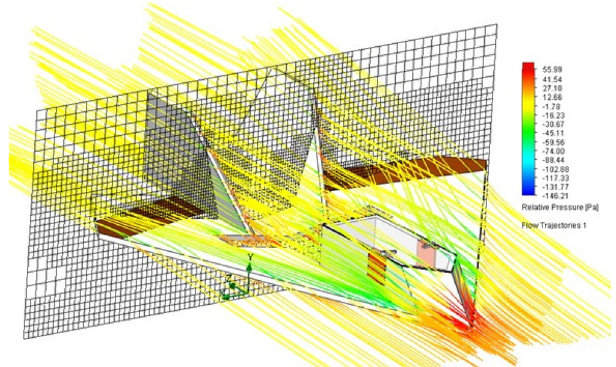
Figure 22. Flow trajectories with relative pressures.